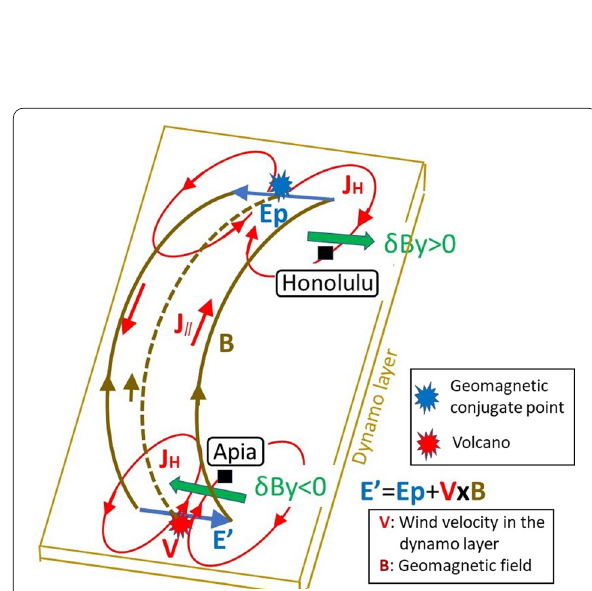
Fig. 11 A schematic illustration on the relation among volcanic eruption, its geomagnetic conjugate point, field-aligned current generation, electric field mapping, ionospheric current (Hall current), its magnetic effect on the ground. In this figure, the symbol ‘ V ’ indicates the neutral atmospheric velocity in the ionospheric dynamo layer (mainly E-layer) caused by the eruption, Ep denotes polarized electric field, and V B indicate the Lorentz electric ×